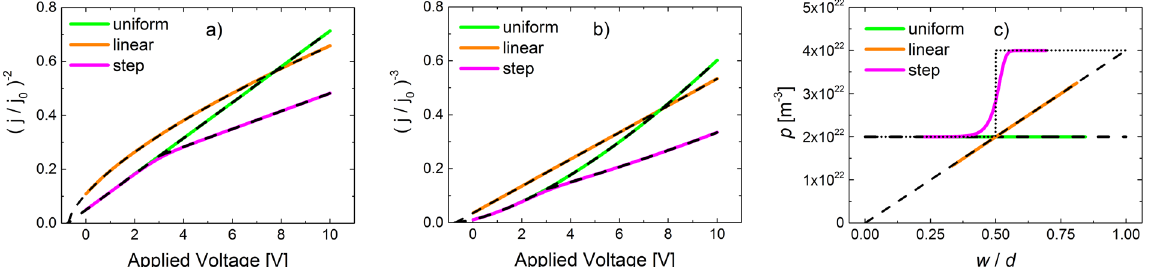
2 2 2 assuming 0